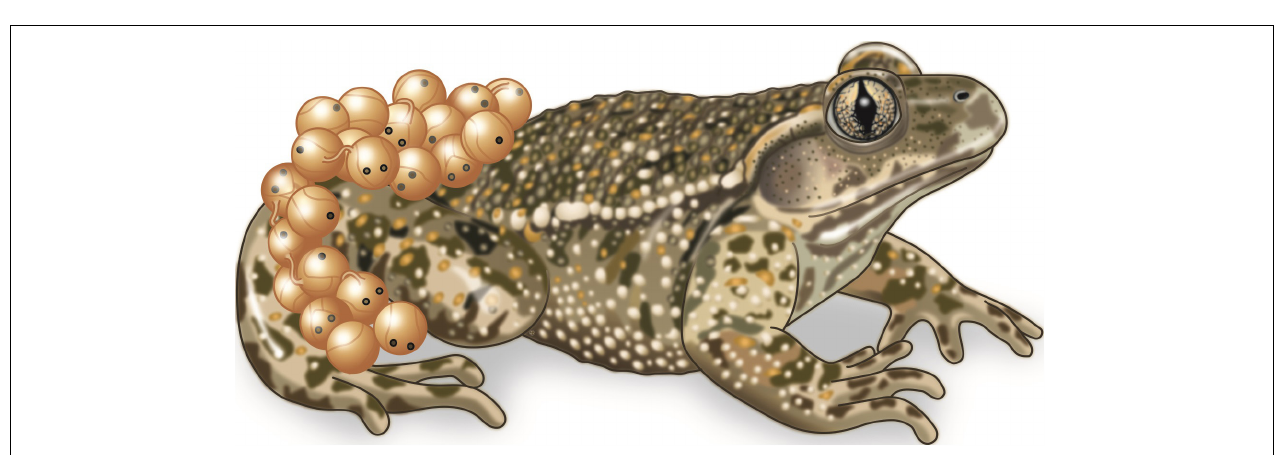
FIGURE 2 | Male midwife toad ( Alytes obstetricans ) carrying a string of developing embryos. Drawing by Bas Blankevoort, copyright Naturalis Biodiversity